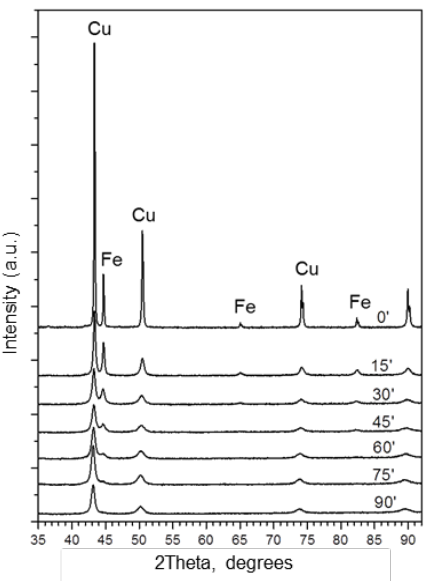
Figure 2. XRD patterns of the 67Cu–33Fe powders ball-milled for 0 min, 15 min, 30 min, 45 min, 60 min, 75 min and 90 min. “Cu”—Cu(Fe) fcc solid solution; “Fe”— α -Fe